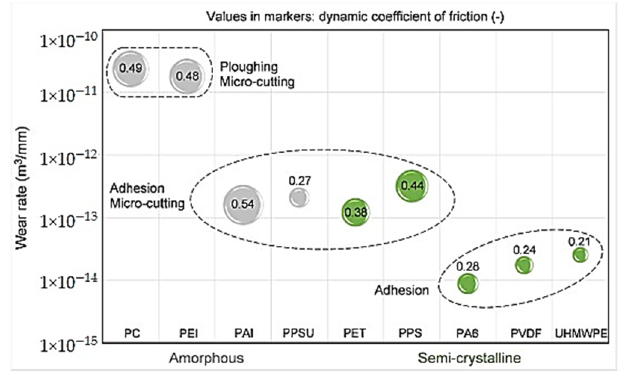
Figure 16. The WR vs. dynamic CoF diagram for amorphous and semicrystalline thermoplastics. Figure is reproduced with permission from reference [113].